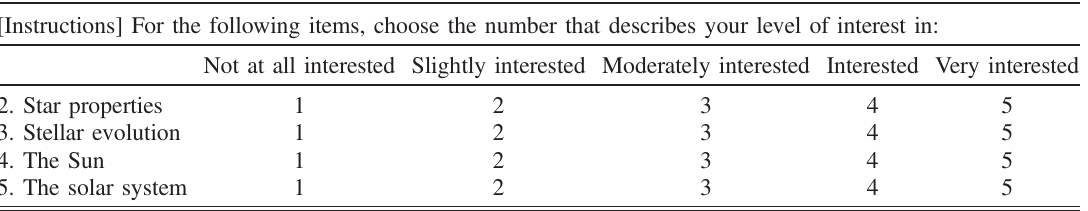
TABLE II. Interest instrument, administered as Items 2 – 5 in the combined survey. [Instructions] For the following items, choose the number that describes your level of interest